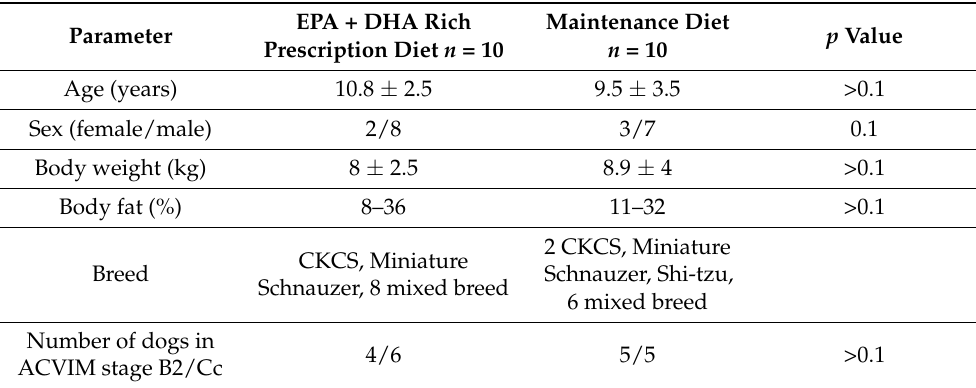
Table 1. Clinical data of enrolled dogs at the start of the